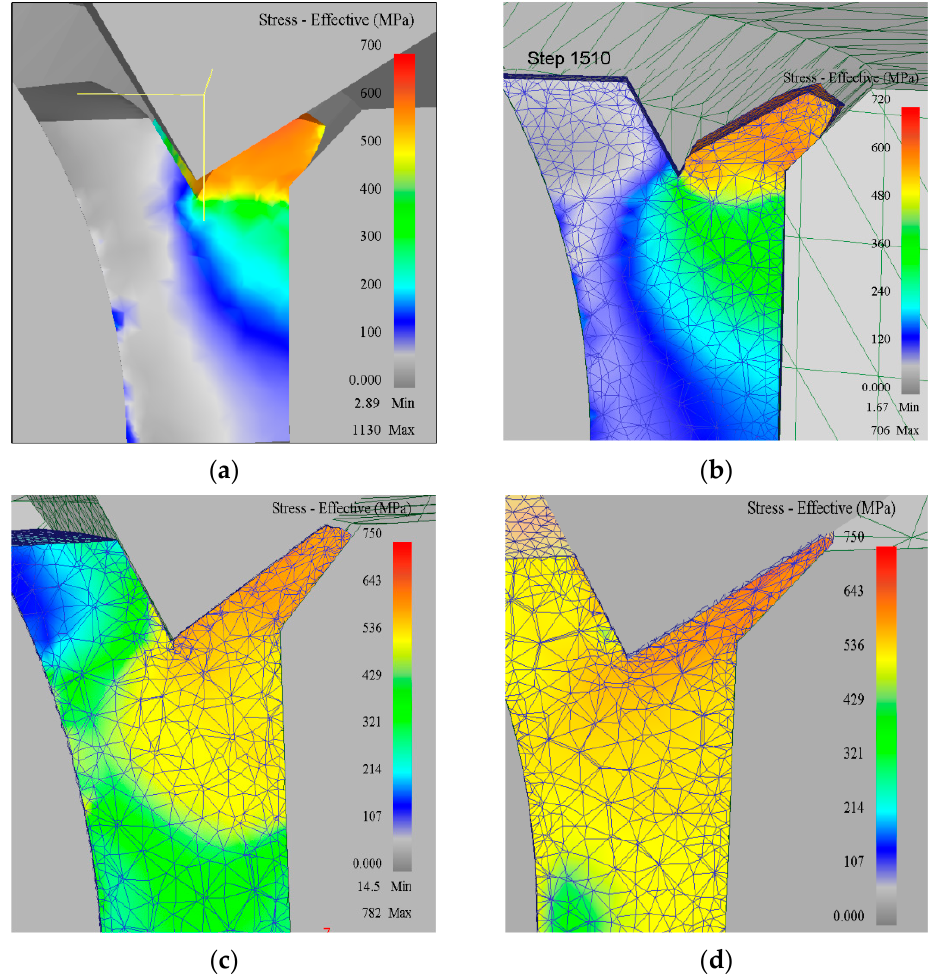
Figure 6. Flanging lip deformation and equivalent stress of the outer ring in the latter four states: ( a ) Equivalent stress of “State 2”; ( b ) Equivalent stress of “State 3”; ( c ) Equivalent stress of “State 4”; ( d ) Equivalent stress of “State 5”.